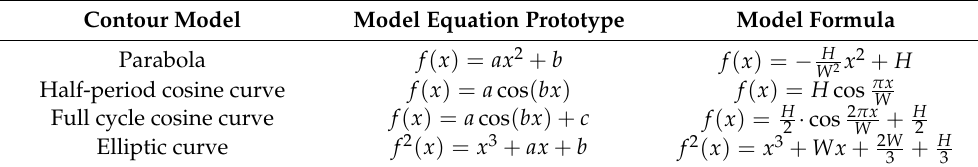
Table 3. Mathematical model of the cross-sectional profile of the specimen.